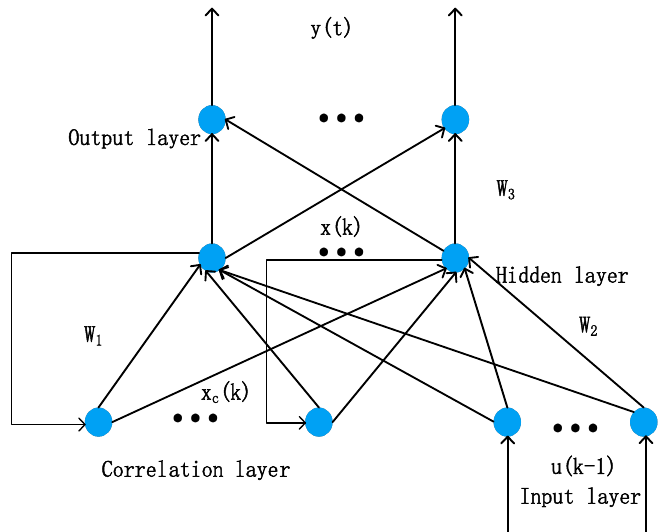
Figure 20. Structure diagram of the Elman Figure 20. S tructure diagram of the Elman network.